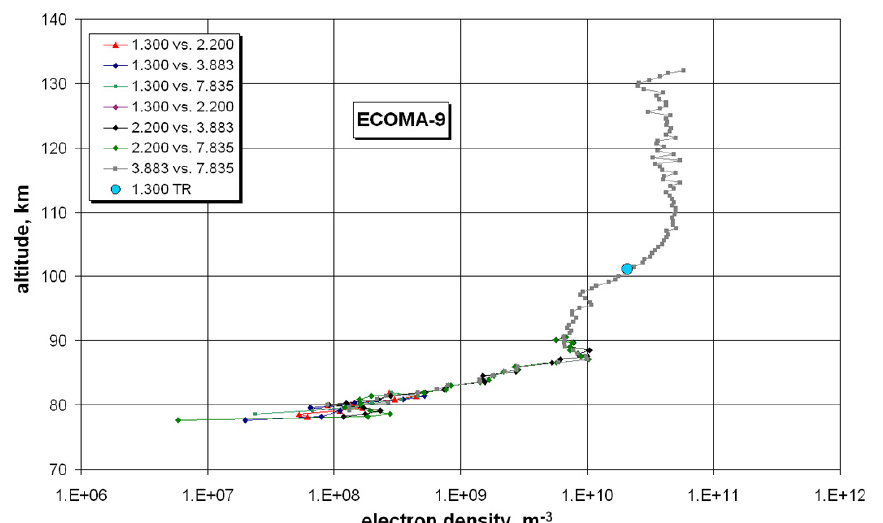
Fig. 8. As Fig. 2, but flight